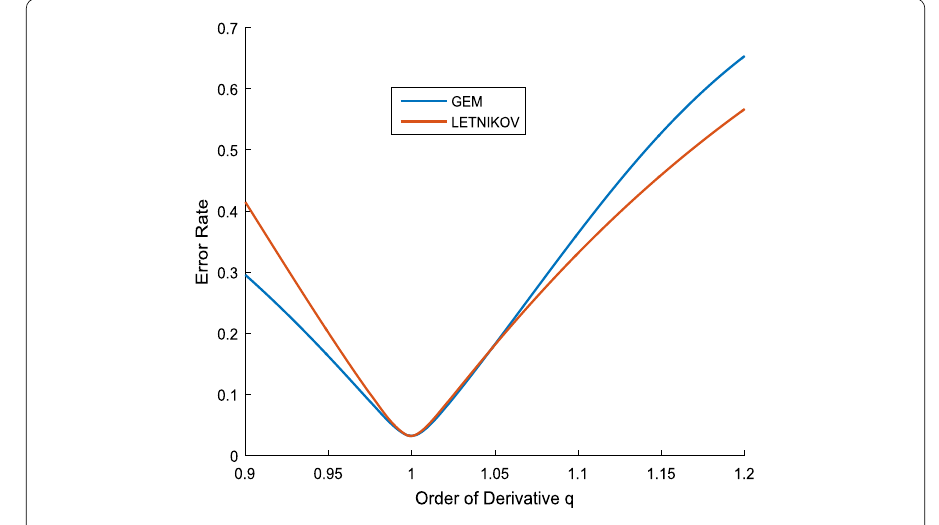
Figure 2 GEM and PSE error rate versus q values